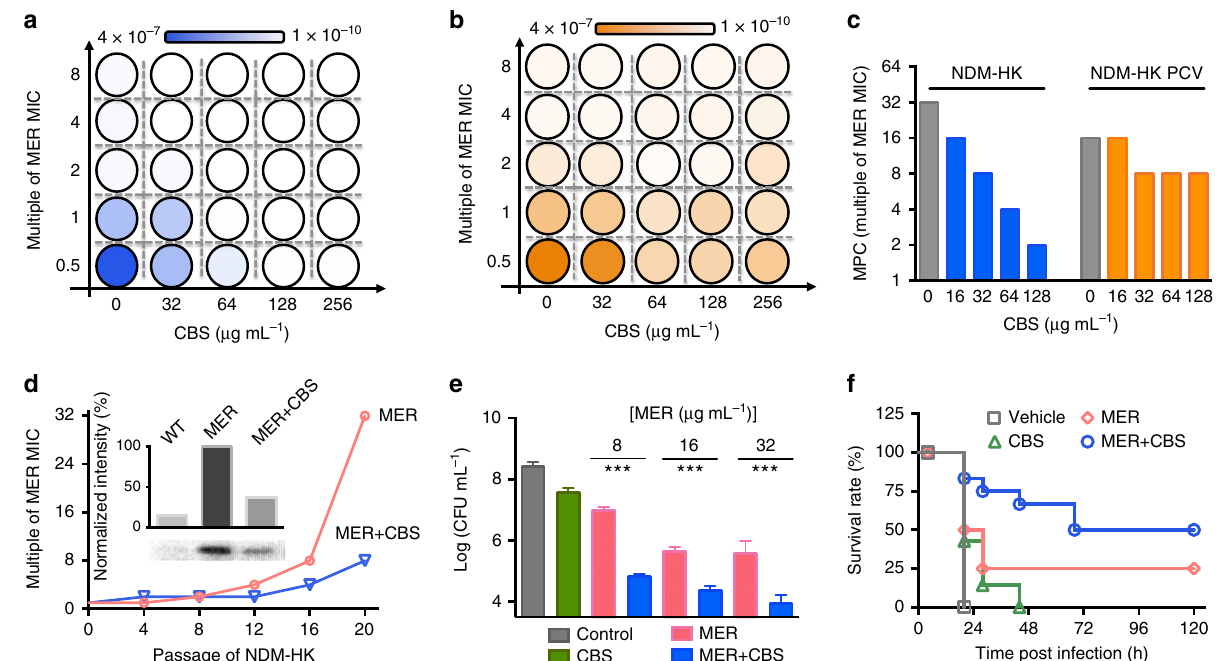
Fig. 4 CBS suppresses the evolution of NDM-1 and boosts the antimicrobial activity of MER for the treatment of NDM-1-positive bacterial infection. a , b Heat plot visualizing the mutation frequency of ( a ) NDM-HK and ( b ) NDM-HK PCV exposed to MER in the presence of increasing concentrations of CBS. c Bar chart showing MPC values of MER in the presence of increasing concentration of CBS against NDM-HK and NDM-HK PCV. d Resistance acquisition curves during serial passage with the subinhibitory concentration of MER or combination of MER and CBS against NDM-HK. MIC test was performed every four passages. The inset shows the normalized expression level (by Western blot) of NDM-1 in the WT NDM-HK, 20 th passage of NDM-HK selected by MER or by combination of MER and CBS. Original western blots is shown in Supplementary Figure 10. e Bar chart showing associated-bacterial load in the in vitro infection model. The concentrations ( μ g mL − 1 ) used are 8, 16, and 32 μ g mL − 1 for MER and 32 μ g mL − 1 for CBS. f Survival curves showing ef fi cacies in a murine peritonitis infection model with the use of mucin. BALB/c mice were infected by a lethal dose of NDM-HK via intraperitoneal injection. Four groups of mice were treated with vehicle control, monotherapy of MER (5 mg kg − 1 ), CBS (20 mg kg − 1 ), or combination therapy of MER and CBS. P < 0.001, Mantel – Cox test, signi fi cant difference from the vehicle control. Eight mice per group were used in vehicle control, monotherapy of MER, or CBS and 12 mice per group in the combination